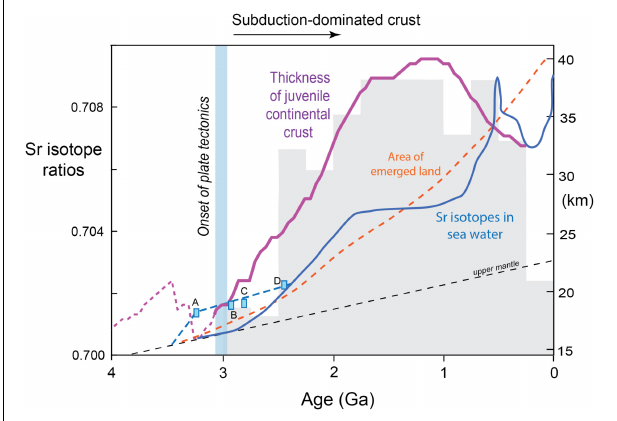
FIGURE 9 | Variations in the thickness of continental crust at the sites of crust generation through time, as estimated from the Rb/Sr ratios of juvenile crust ( Figure 8 ) and the changes in Rb/Sr vs. crustal thickness in recent magmatic rocks from the Central and South America (Dhuime et al., 2015). The curve for Sr isotopes in seawater is from Shields and Veizer (2002), and the dashed portion is from Satkoski et al. (2017). A is granular barites (Satkoski et al., 2016), B is carbonate from Red Lake, and C is from Steep Rock in the Superior Province (Satkoski et al., 2017), and D is from the Campbellrand carbonate (Kamber and Webb, 2001). The gray shaded histogram illustrates the secular variation in the proportion of subaerial LIPs (Kump and Barley, 2007). The curve for the proportion of emerged land is from Flament et al. (2013), and it increases from 0% at 3.5 Ga to the present day value of